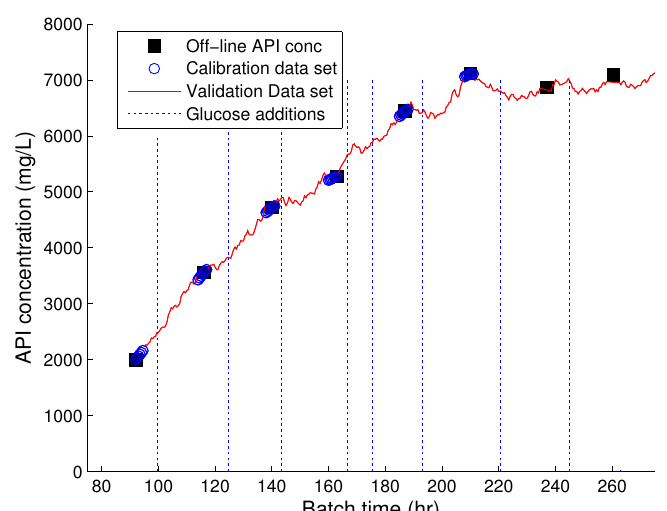
Figure 5. Profile of PLS model of product generated using the spectra collected from the 993 nm Raman device and the corresponding off-line concentrations of the API concentration. The dashed vertical lines represent the time of the glucose